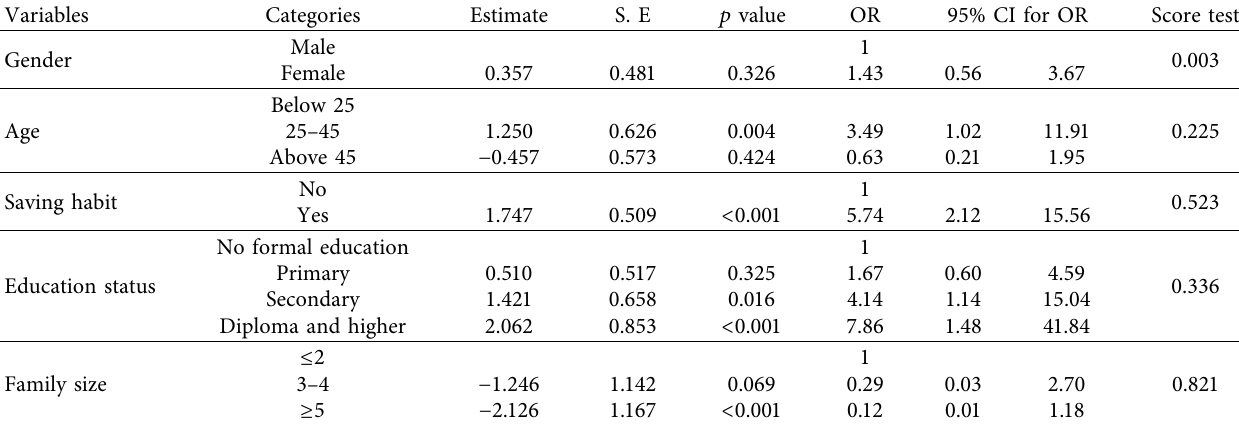
Table 2: Parameter estimates of POM using SES status as response with three-ordered categories.